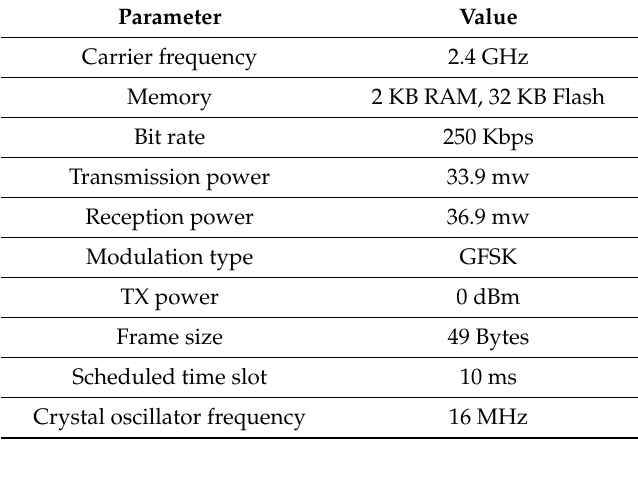
Table 1. Specification of sensor module.